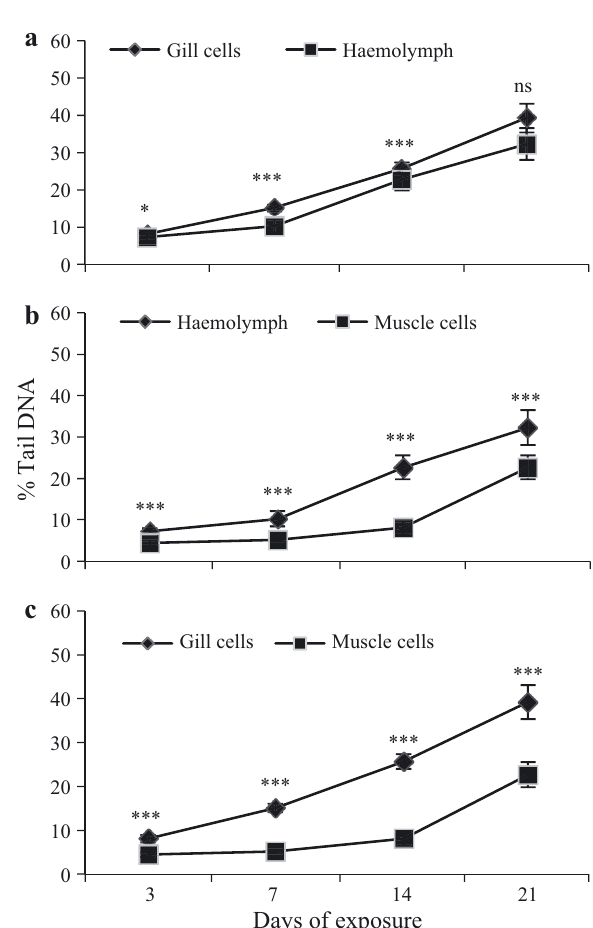
Fig. 4. Comparison of % DNA damage induced by sublethal concentration SL2 (0.18 µg l –1 ) of chlorpyrifos in gill, haemo - lymph, and muscle cells of Litopenaeus vannamei juveniles at the end of 3, 7, 14 and 21 days of exposure. (a) Gill vs. haemolymph, (b) haemolymph vs. muscle, (c) gill vs. muscle. Data are mean ± SD. ns: not significant, *p < 0.05, **p < 0.01, ***p <